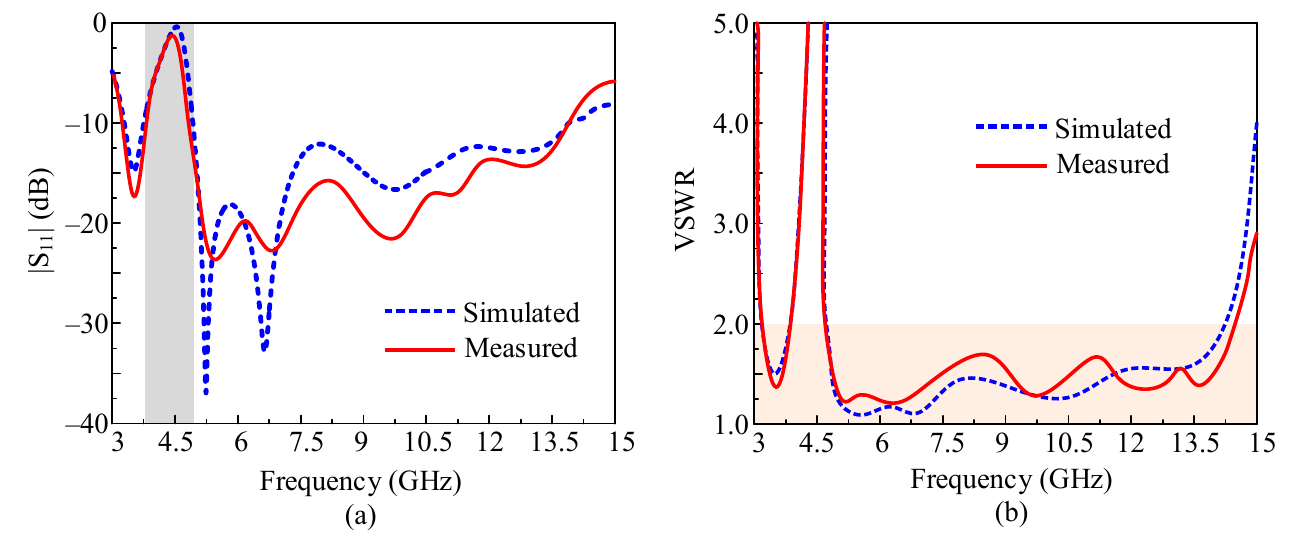
Figure 10. Simulated and measured ( a ) return loss ( b ) VSWR of the proposed antenna.